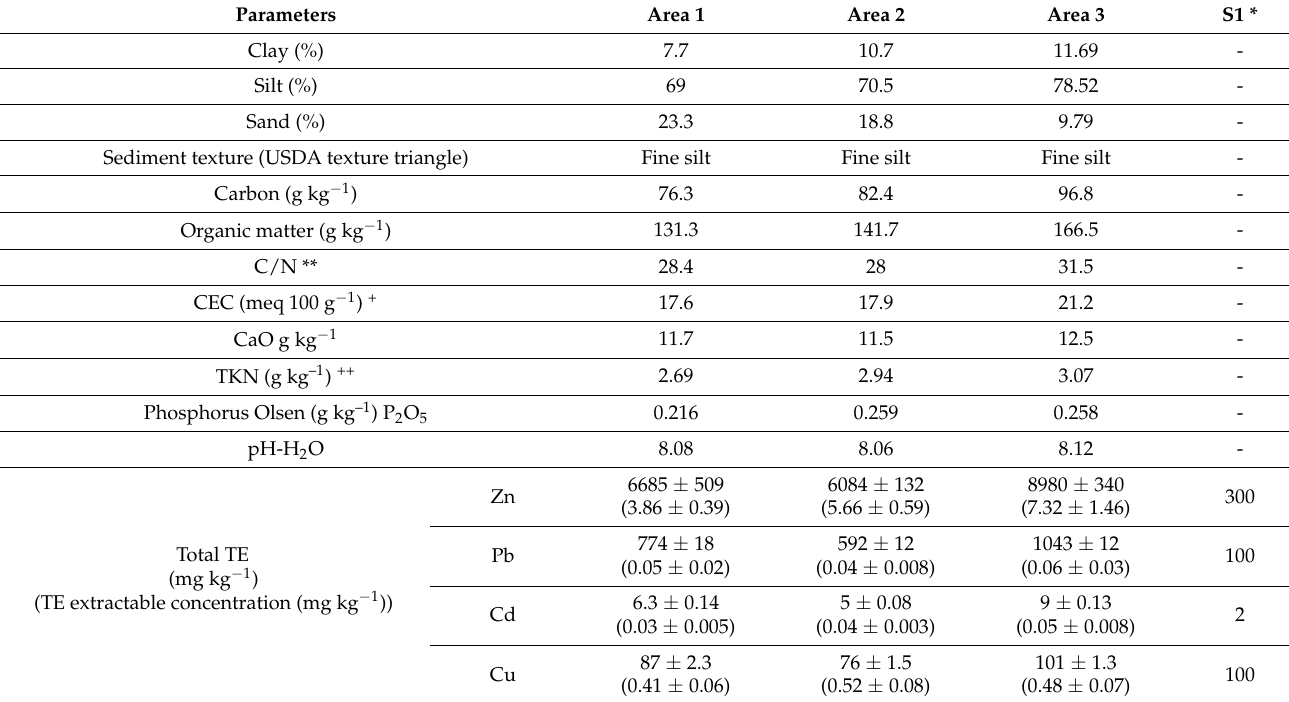
Table 1. Main physico-chemical properties, total and NH 4 NO 3 extractable (between parenthesis) concentrations of TE in the sediment of the field site for each area, and TE threshold values (S1) for sediment management. TE are expressed in mg Kg − 1 DW. With the exception of the sediment parameters ( n = 1), values are means ± standard deviation (SD) ( n = 5 for total TE; n = 3 for NH 4 NO 3